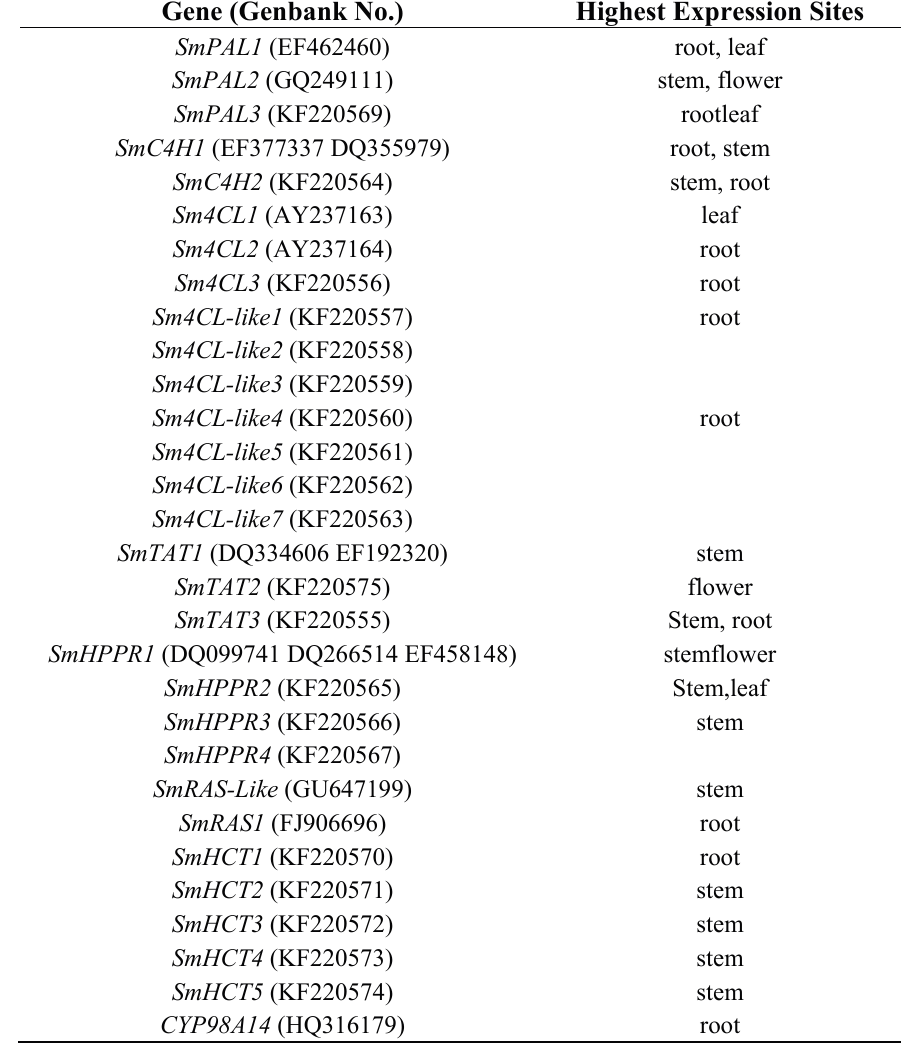
Table 2. The genes involved in phenolic acids biosynthesis in S. miltiorrhiza. Gene (Genbank